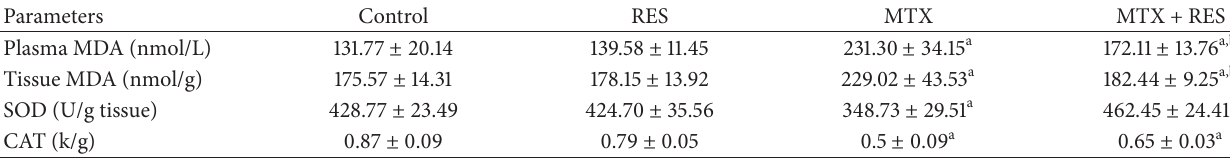
Table 1: Oxidant and antioxidant biochemical parameters in all groups.